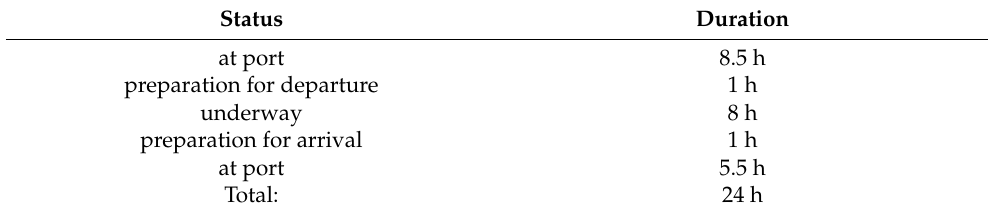
Table 3. Ship’s weekday